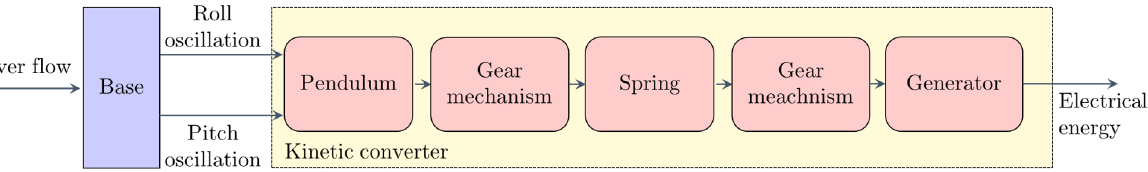
Figure 3. Block diagram representing the river flow kinetic energy